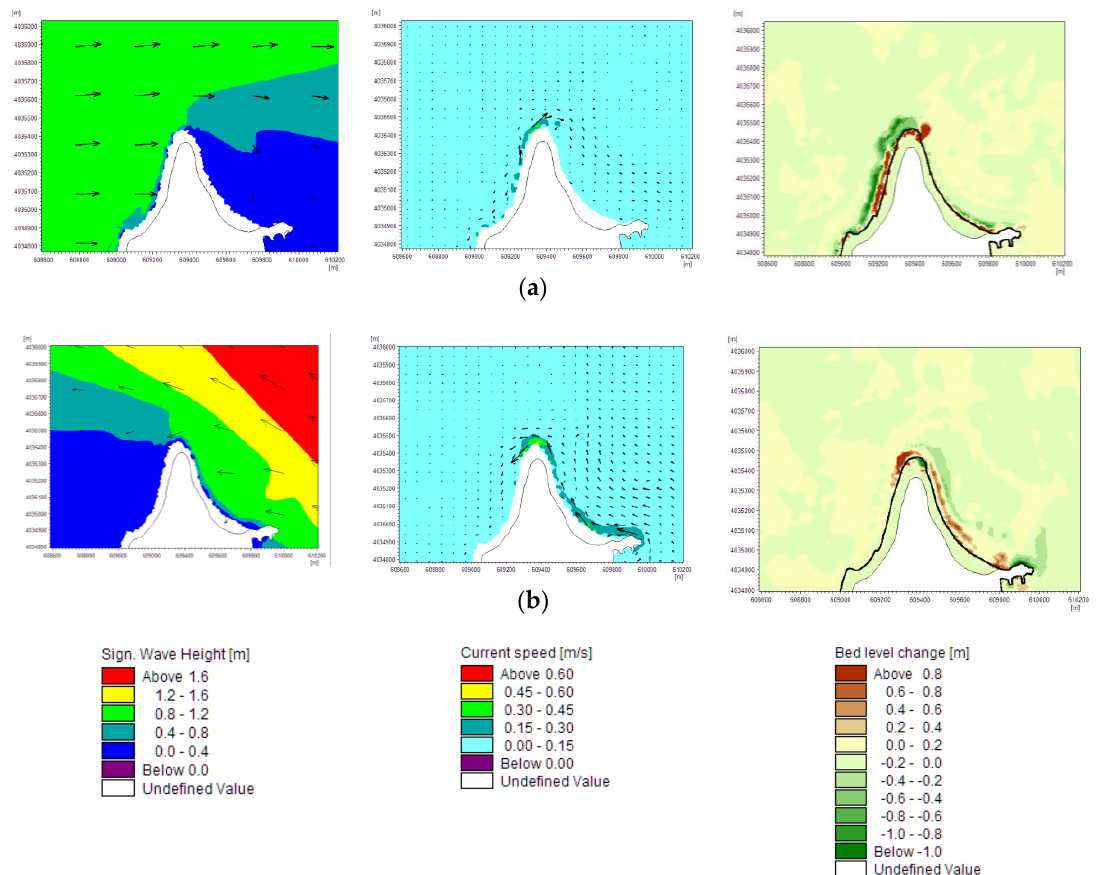
Figure 7. Wave field, littoral drift and bed level change simulation results of ( a ) SW wave scenario (Scenario 1: H m0 = 1.25 m, T p = 6.75, MWD = 255 degN) and ( b ) SE wave scenario (Scenario 3: H m0 = 2.25 m, T p = 6.75, MWD = 135 degN).